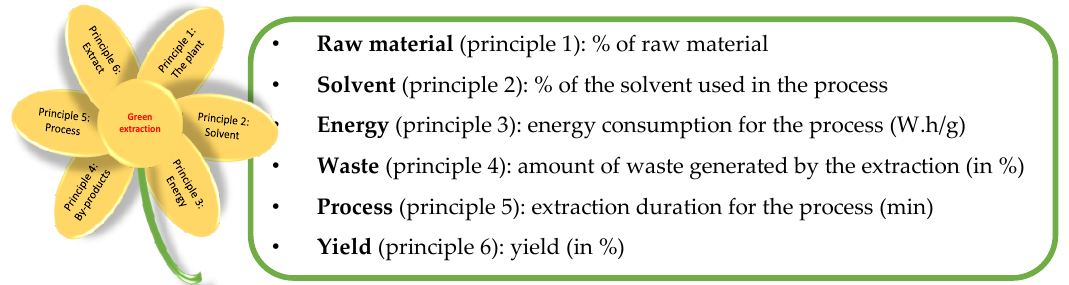
Figure 1. Description of the six principles of green extraction (raw material, solvent, energy, waste, process, and yield).